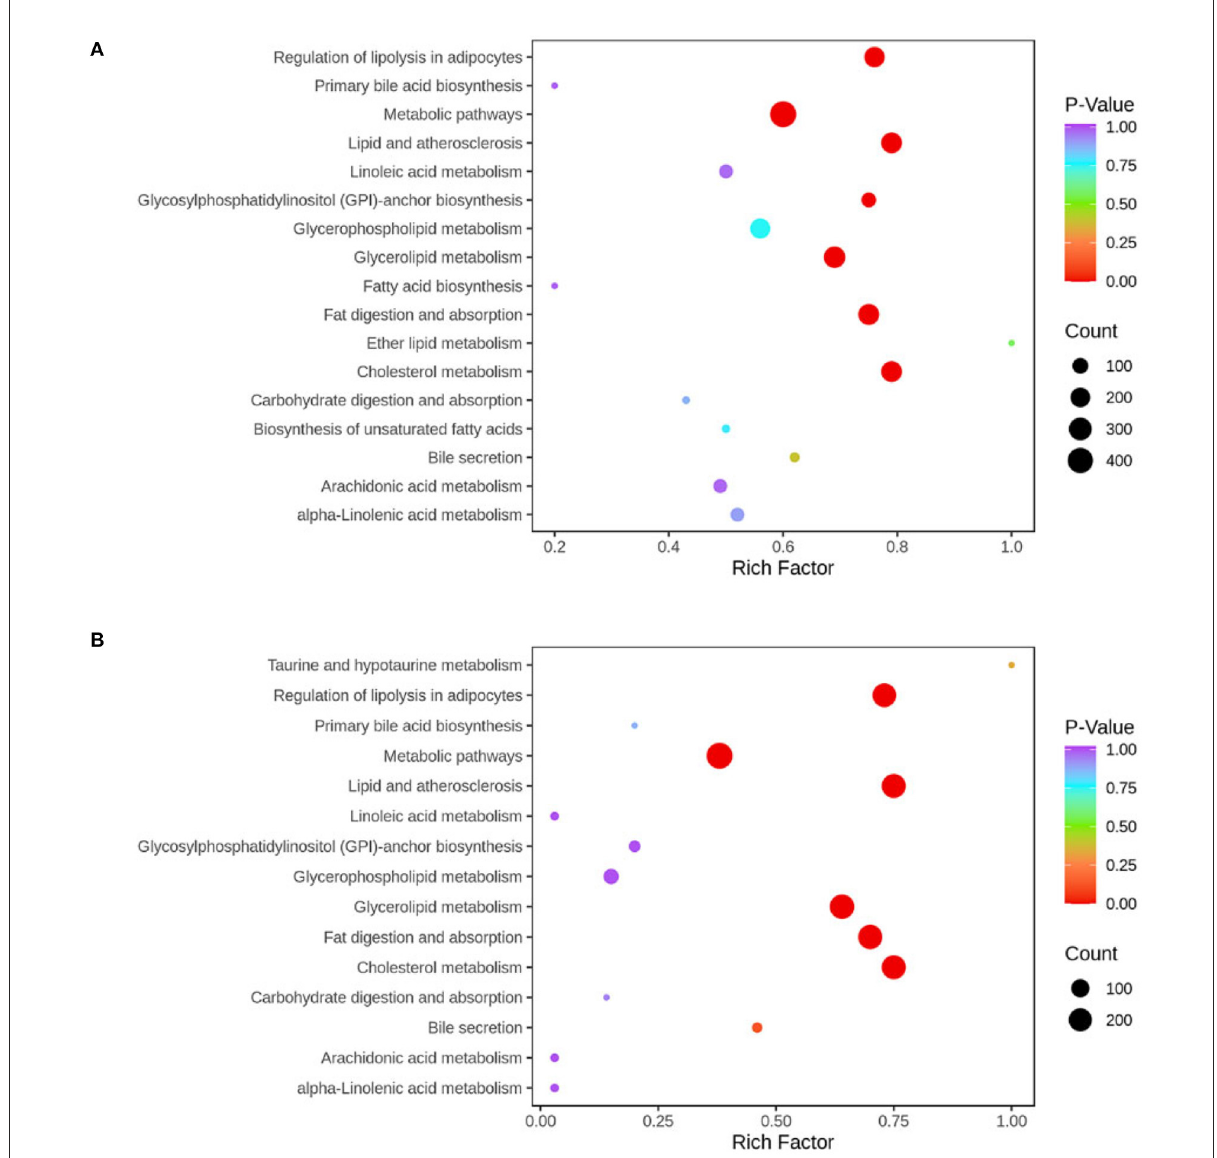
FIGURE9 KEGG pathway was enriched according to the results of differential metabolites in liver tissue. The abscissa represents the Rich factor corresponding to each pathway, the ordinate represents the pathway name, and the color of the point indicates the p -value: the redder the point, the more significant the enrichment. The size of the dot represents the number of enriched differential metabolites. Normal, rats fed a normal diet ad libitum ; MAFLD (metabolic associated fatty liver disease), rats fed a high-fat diet ad libitum ; TRF (time-restricted feeding), rats fed high-fat diet (60 kcal% fat) strictly between 16:00 and 22:00 every day. (A) Normal vs. MAFLD; (B) MAFLD vs.